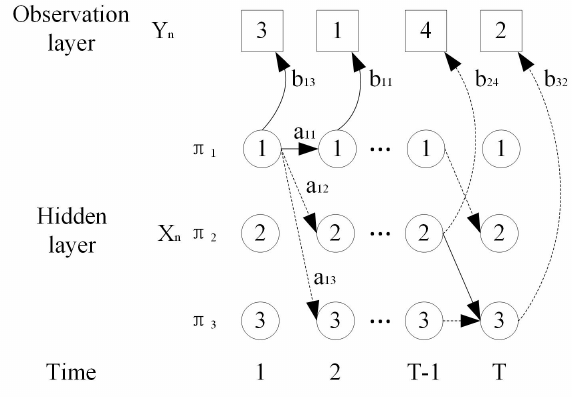
Fig. 2. Schematic diagram of Hidden Markov